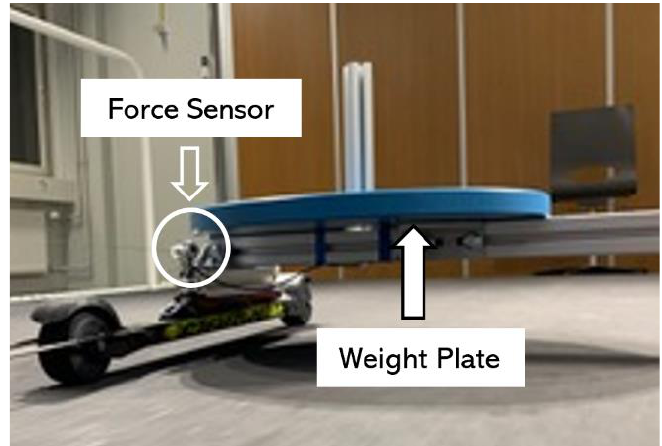
Figure A1. Custom-made friction measurement device.